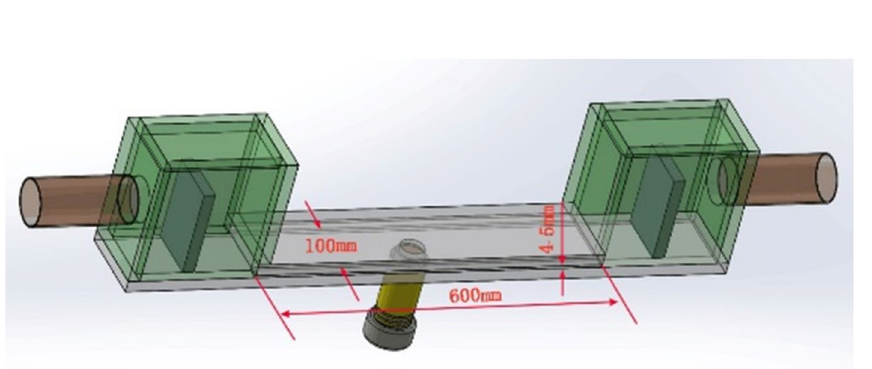
Figure 4. The testing channel of the flow-accelerated corrosion loop